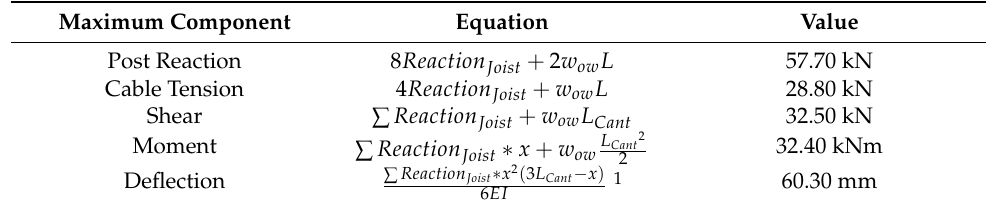
Table A5. Cantilevered system beam load table for a design load of 2.27 kPa.